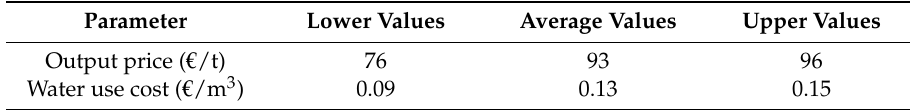
Table A4. Water use cost and output prices for processing tomatoes published by Ghinassi and Zamarchi